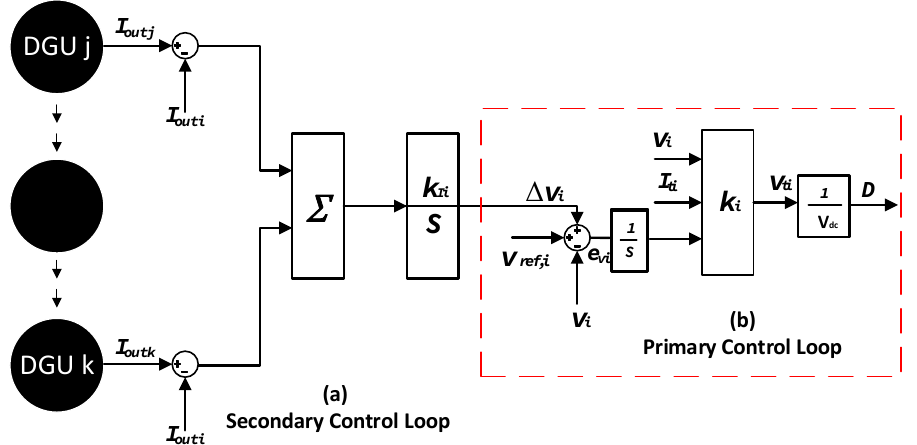
Figure 3. Hierarchical control scheme of the microgrid under study: ( a ) consensus-based secondary controller and ( b ) state feedback primary controller.